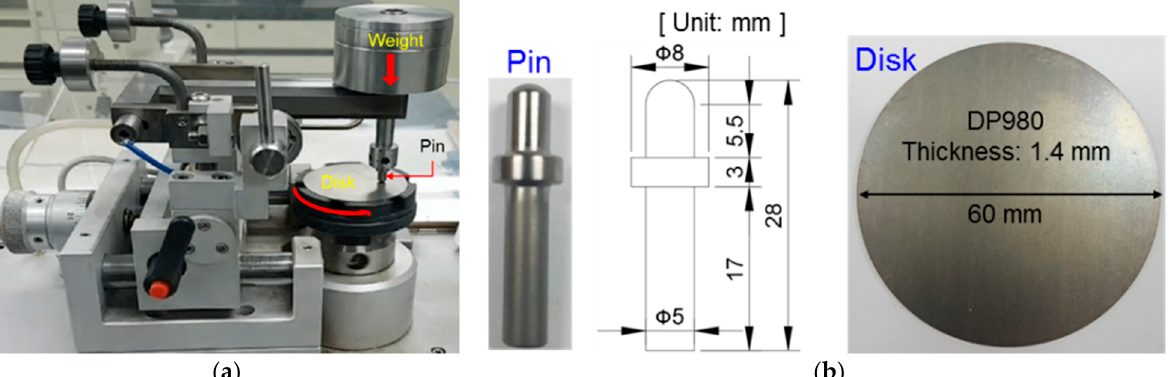
Figure 3. Experimental setup of the pin-on-disk test: ( a ) testing machine; ( b ) geometry and dimension of the pin and the disk.